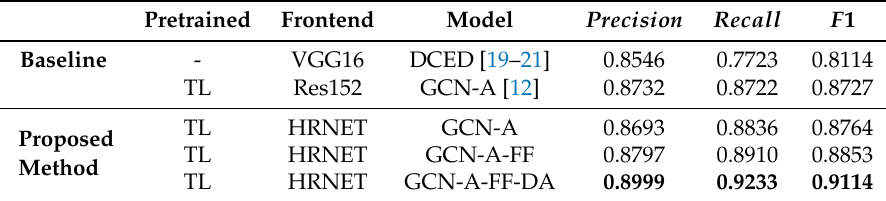
Table 3. Effects on the testing set of the Landsat-8w3c data set.